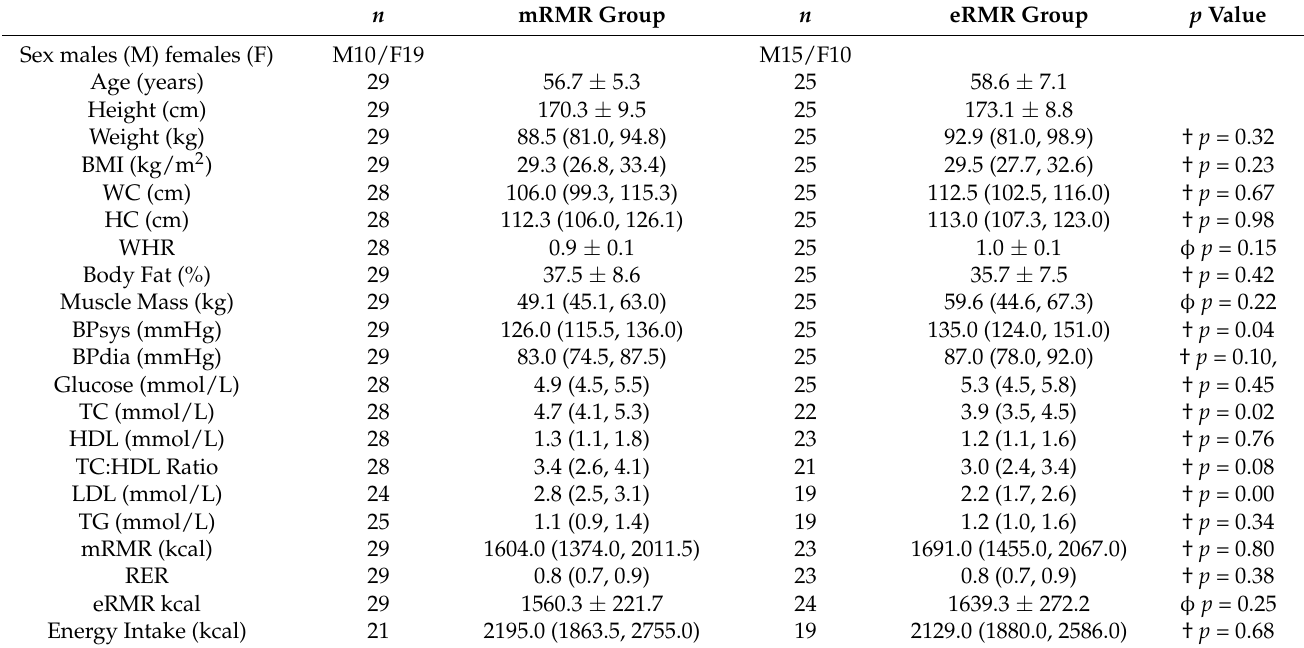
Table 1. Baseline participant characteristics.